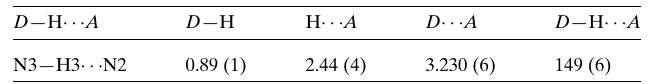
Table 1 Hydrogen-bond geometry (A˚ , (cid:4) ).